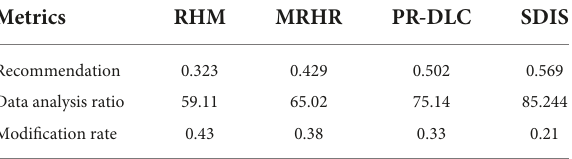
TABLE 4 Comparative analysis for varying C m